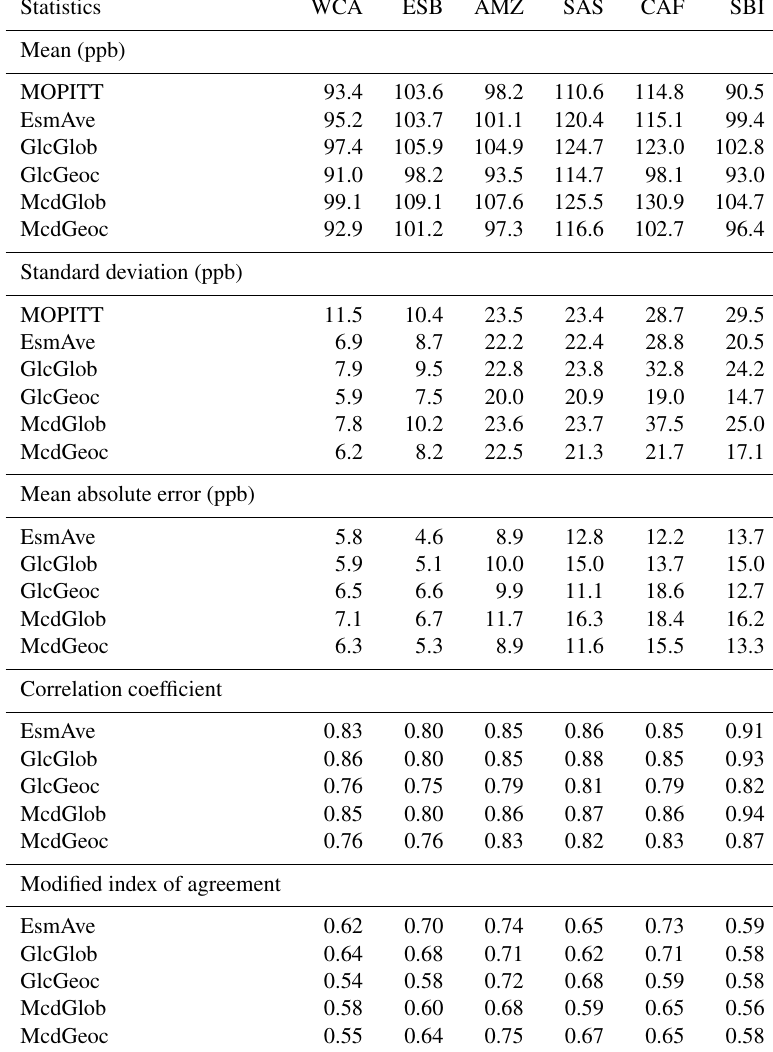
Table 6. As Table 5 but for observed and simulated XCO (ppb) fields over the six selected areas: SEN, ESB, AMZ, SAS, CAF, and SBI between 2013 and